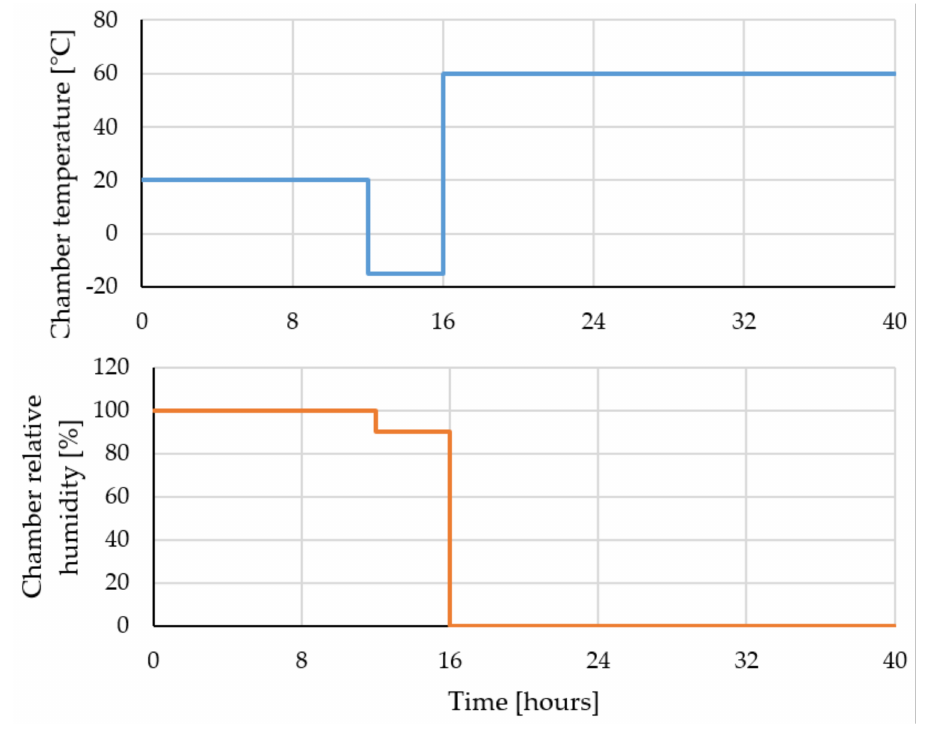
Figure 13. One freeze/thaw